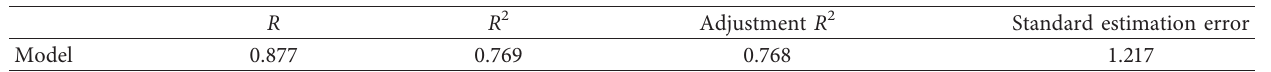
Table 9: Model summary.